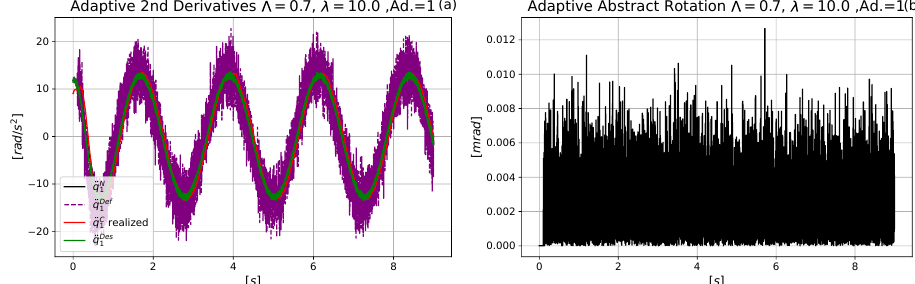
Figure 13. The operation of the adaptive controller for smaller amplitude and high circular frequency of the nominal motion. ( a ): The desired, deformed, and realized 2nd time-derivatives. ( b ): The angle of the adaptive abstract rotation.